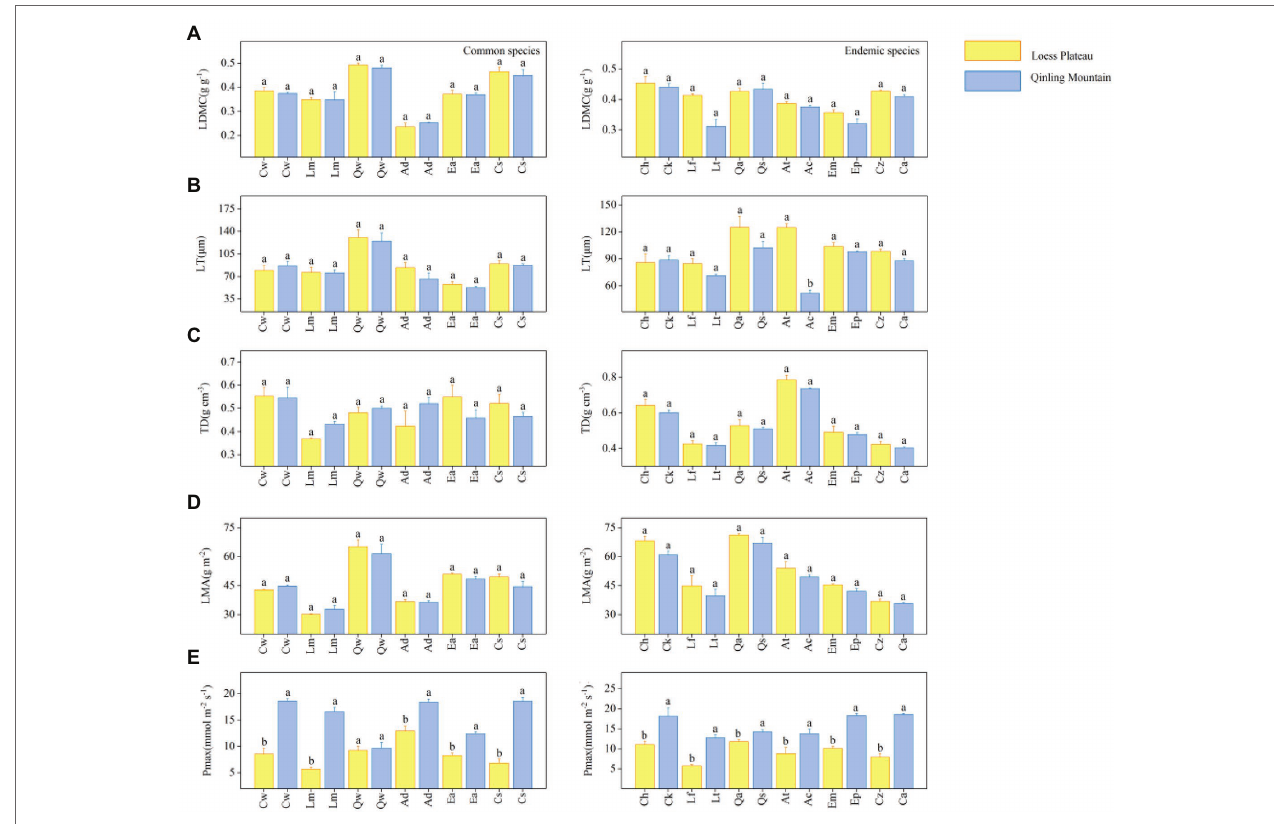
FIGURE 3 | Five economic traits: (A) Leaf dry matter content (LDMC), (B) Leaf thickness (LT), (C) Leaf tissue density (TD), (D) Leaf mass per area (LMA), and (E) Maximum net photosynthetic rate (P max ) for 18 special congeneric pairs of species (common species and endemic species in six genera) in Loess plateau (low soil water availability) and Qinling Mountain (high soil water availability). The species abbreviations are shown in Figure 1 . Error bars represent 1 SE, and different letters indicate significant differences between regions ( p <